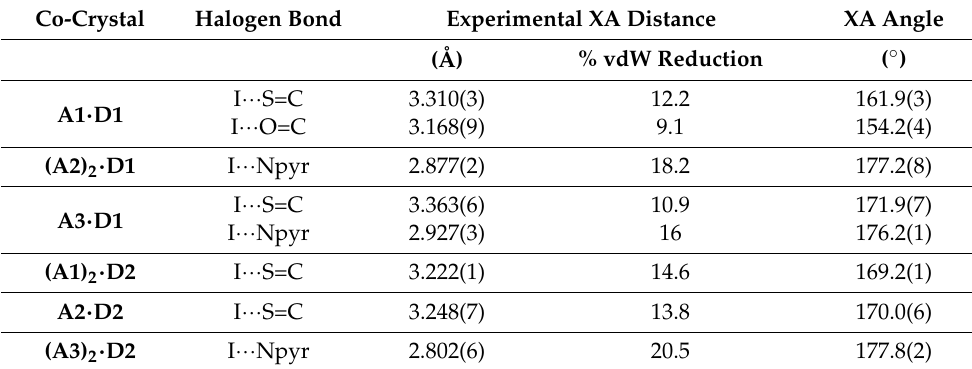
Table 1. XA distances and angles from crystal structures.